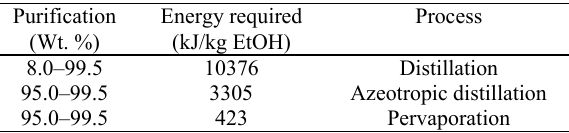
Table 1 Energy requirements for ethanol dehydration Table 1: Energy requirements for ethanol dehydration [10]